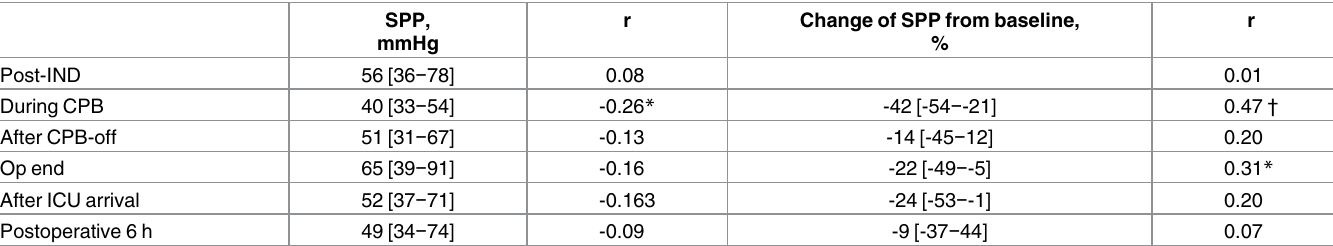
Table 1. Perioperative SPP values and their associations with the postoperative 6 h peak lactate level.